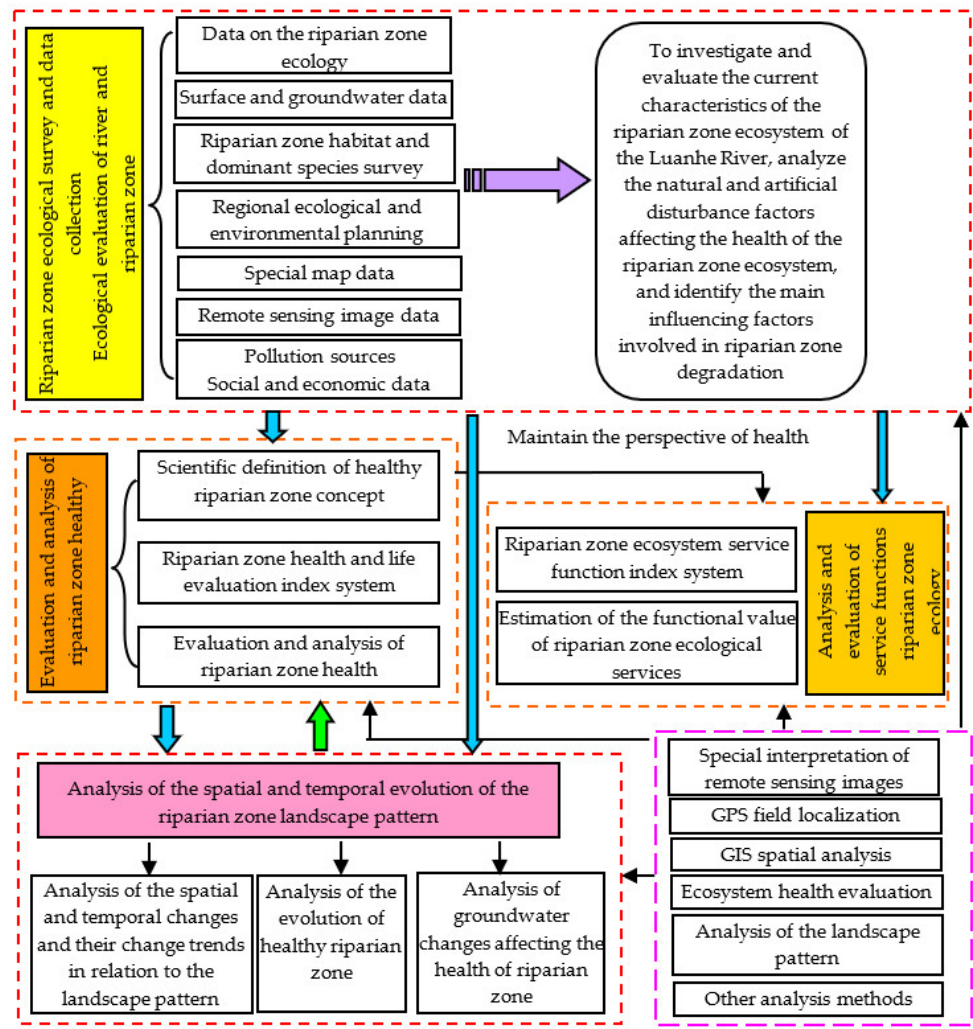
Figure 3. The working procedure used for the river health assessment.